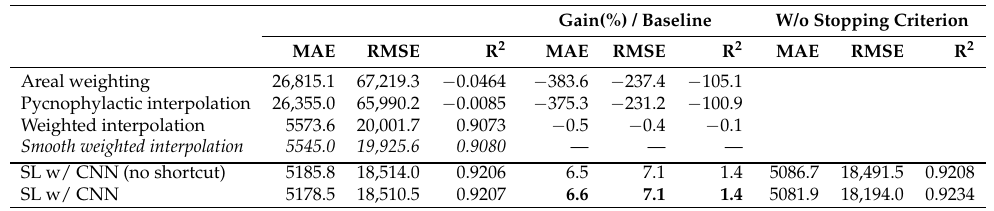
Table 5. Results obtained with different disaggregation methods for the amount of national with- drawals during the summer